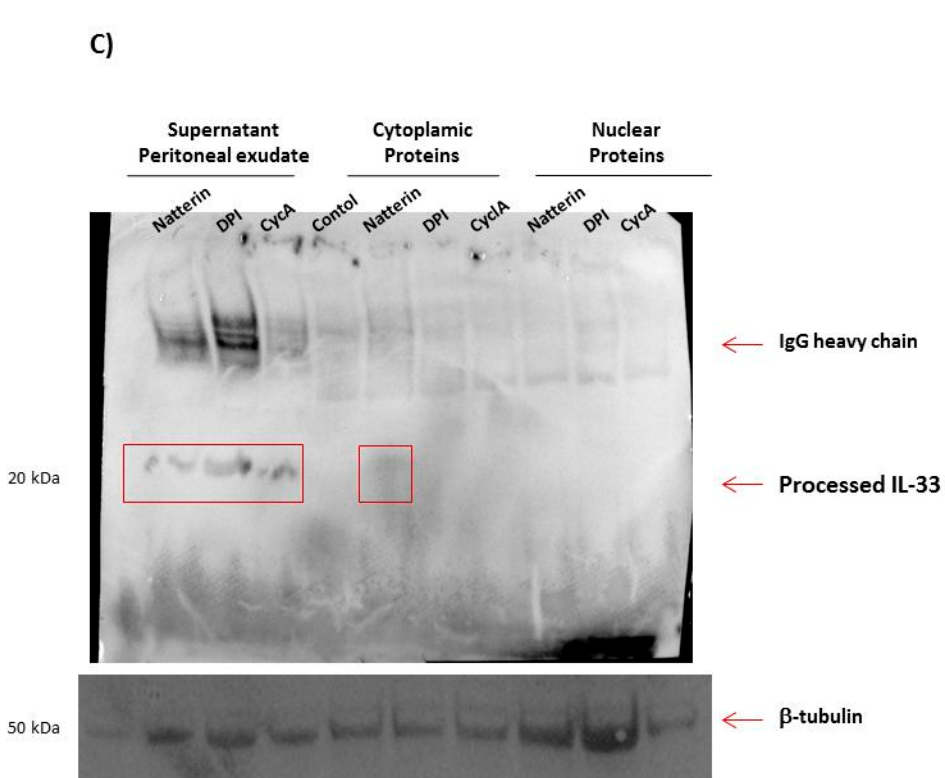
Figure 2. Mitochondrial dysfunction and IL-33 induced in Natterin response. Natterin (1 μ g) diluted in PBS was injected i.p. in BL6 WT mice previously treated for 1 h with i.p. injection of cyclosporin A at 10 μ M ( WT CycA_Natterin) or DPI at 100 μ M ( WT DPI_Natterin) ( A ). As a negative control, mice were injected i.p. with PBS ( WT _PBS). As a positive control, mice were only injected with Natterin ( WT _Natterin). Two hours after injection, mice were killed and the peritoneal cavities were washed to obtain exudates. Peritoneal exudate cells were harvested and the number of neutrophils related to total cell number was evaluated in cytospin slides stained with the Diff-Quick staining